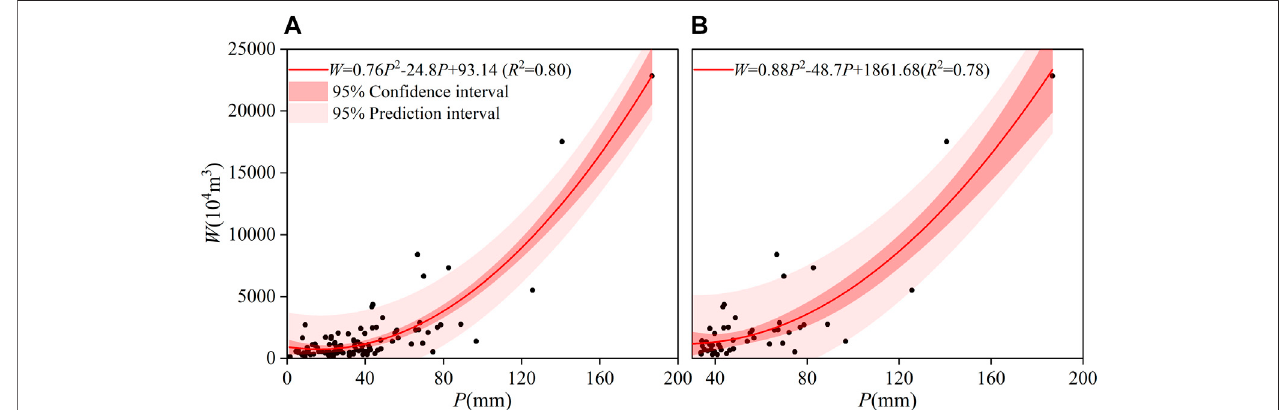
FIGURE 7 | Method of sub-rainfall fi tting: (A) for all rainfall; (B) for extreme rainfall events.